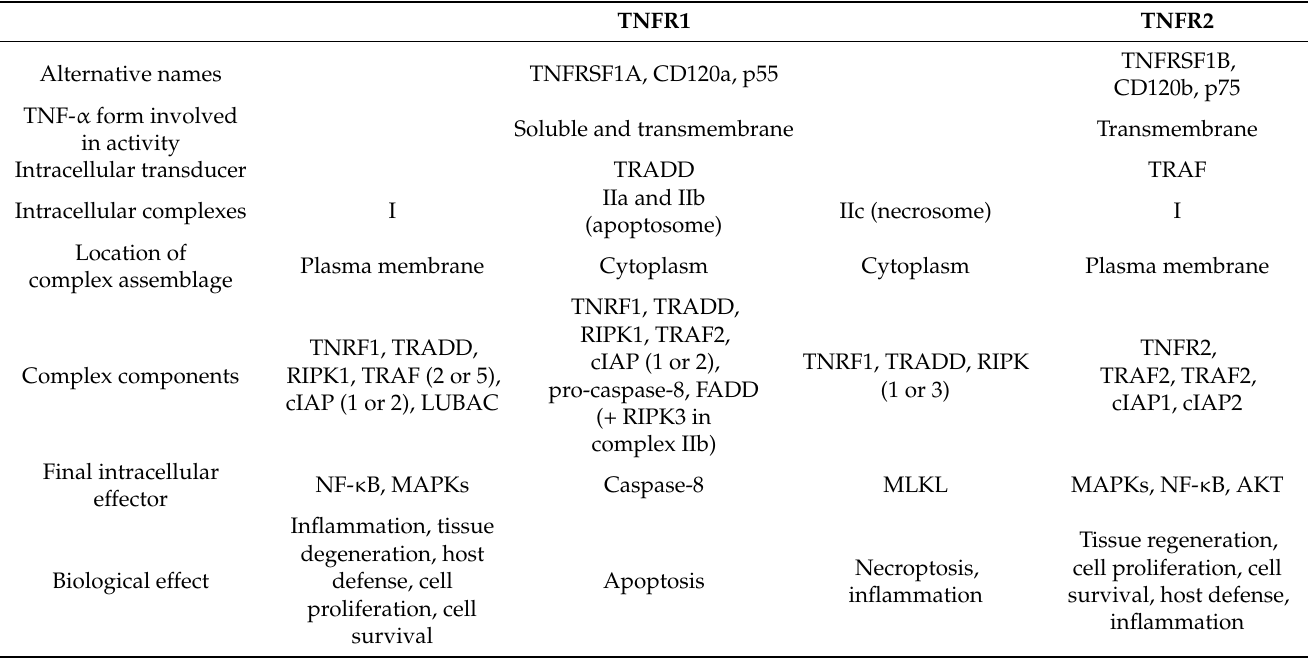
Table 2. Main mechanisms of action involved in activation of TNF- α receptors and main biologic